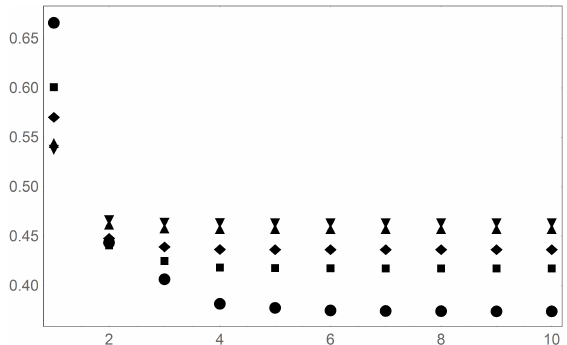
Figure 8. Behavior of the saturation of prime powers, q m for q = 3 (circle); q = 5 (square); q = 7 (diamond); q = 11 (triangle); and q = 13,(inverted triangle). The vertical axis is s and the horizontal axis is m